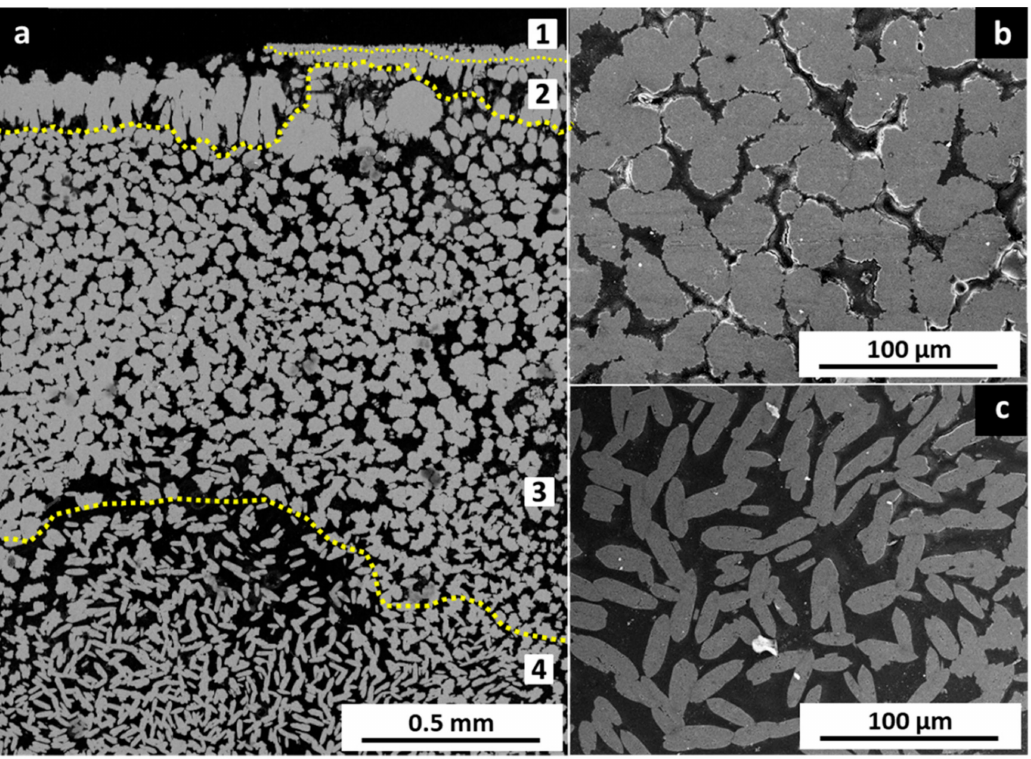
Figure 5. ( a ) The celestite layer can be divided in four regions. Fine grained celestite crystals constitute Region 1, which is located in the most outer part of the pseudomorph. Moving inwards, the region that appears closest to Region 1 consists of celestite elongated crystals in a stockade-like layer arrangement (Region 2). This is followed by a highly porous region defined by spherulitic aggregates (Region 3). Finally, the most inner region of the pseudomorph is even more highly porous and is built up of sparsely distributed prismatic crystals that leave large hollow spaces between them (Region 4). ( b ) The spherulitic crystals that constitute Region 3 are gradated in size, with the smallest ones located closer to the boundary with Region 2 and the largest ones appearing closer to Region 4. These crystals have Ca contents that are similar to those found in the celestite crystals that build up Regions 1 and 2. ( c ) The prismatic crystals that constitute Region 4 have a prismatic habit and contain no Ca, according to their EDX